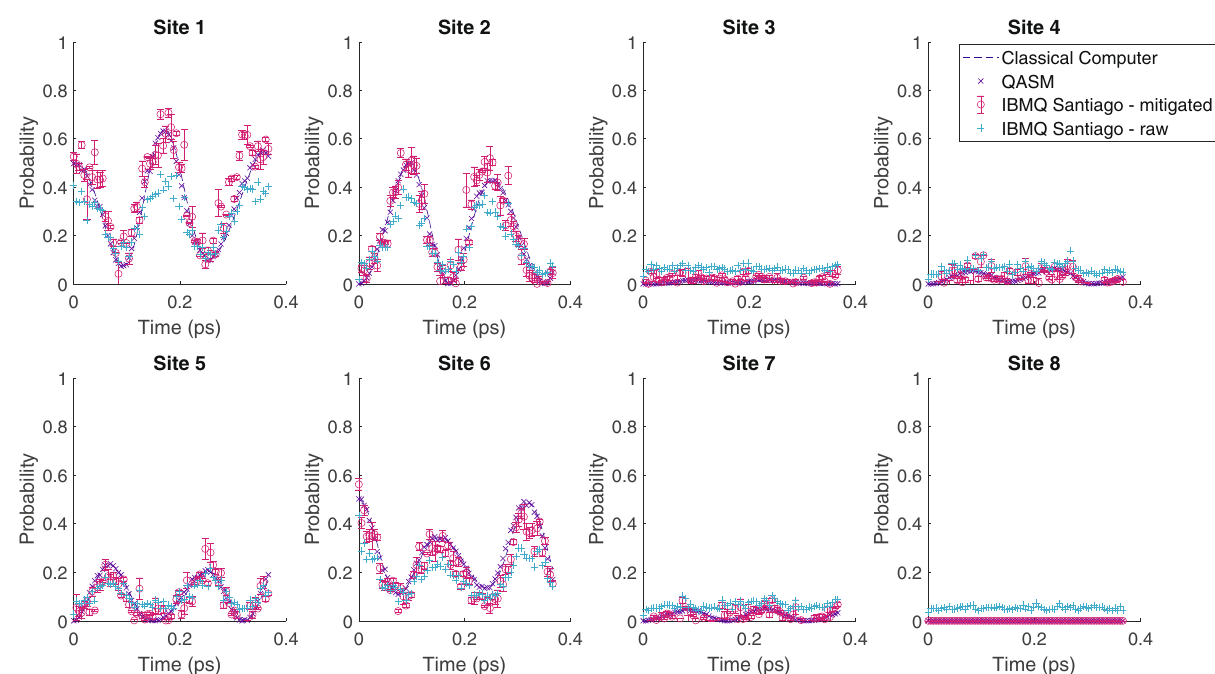
Fig. 3 Unitary evolution of the site populations in the seven-site Fenna – Matthews – Olson molecule. Each point is an average over three jobs of 8192 shots each. The error bars are deduced from the discrepancies between the three jobs. The initial position of the simulated energy excitation is a pure superposition across sites 1 and 6. Due to noise, the excitation is sometimes detected in site 8, even if this site does not participate in the